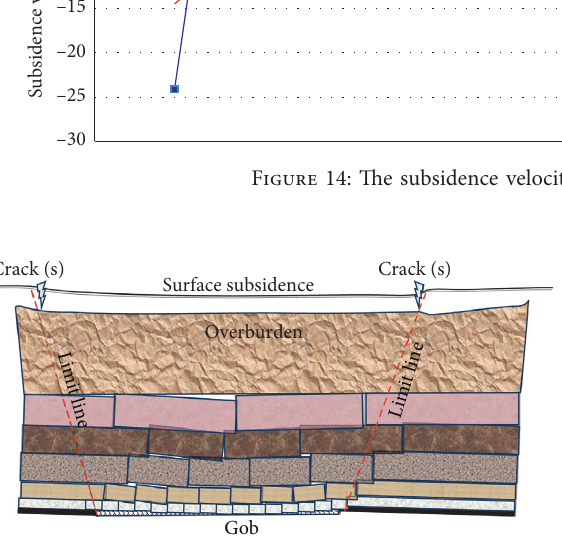
Figure 15: The inference for explaining the control effect of strata structures on subsidence.